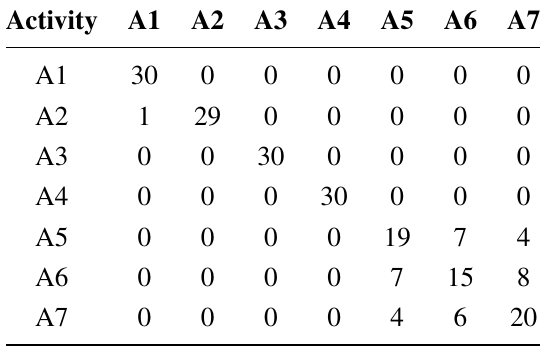
Table 7. Confusion matrix for Hockey Smartphone data for Experiment 2.